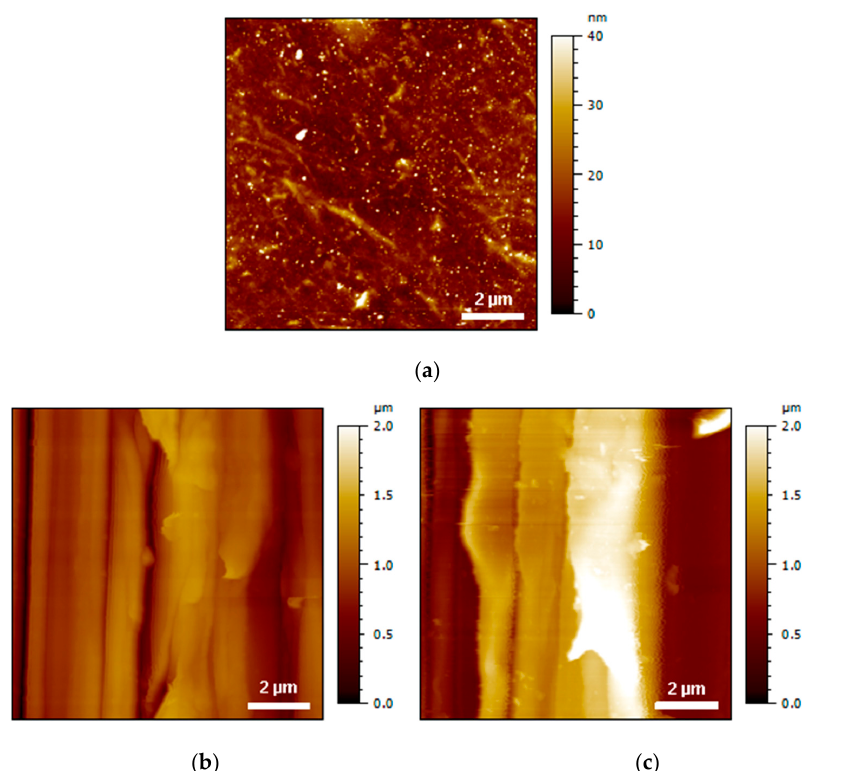
Figure 4. AFM 2D height images of PI film ( a ) before and ( b ) after grinding + cleaning + drying surface treatment and ( c ) after grinding + cleaning + drying + PDA coating surface treatment.